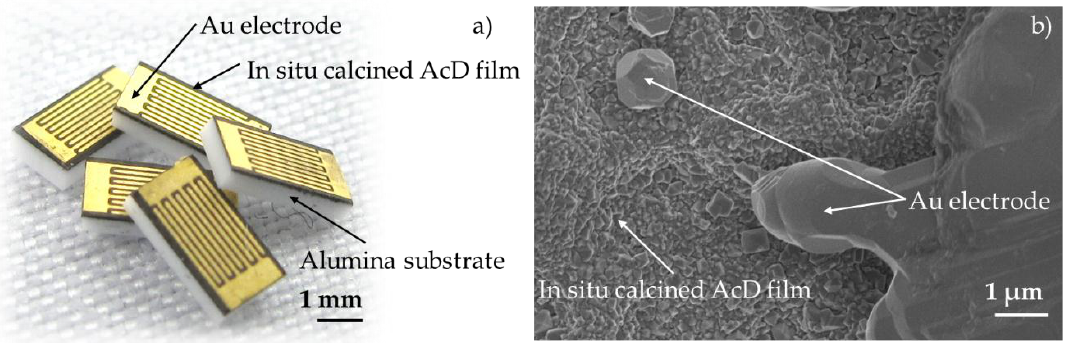
Figure 7. Finished chip-based NTCR sensor after completion of multifunctional temperature treatment ( a ) photograph and ( b ) SEM image of the surface.